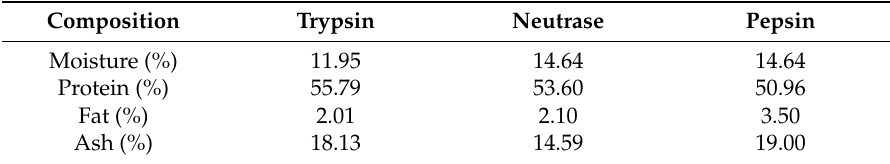
Table 1. Proximate composition of hydrolysates from R. philippinarum proteins.